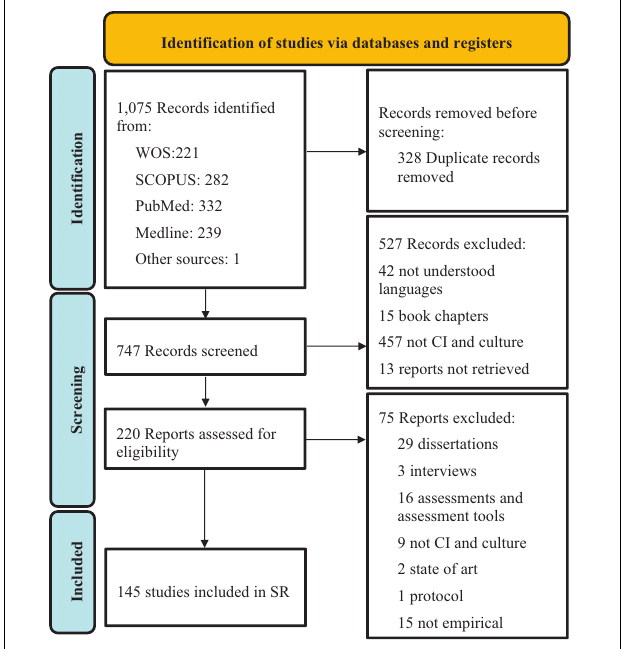
FIGURE 1 | PRISMA flow chart of included